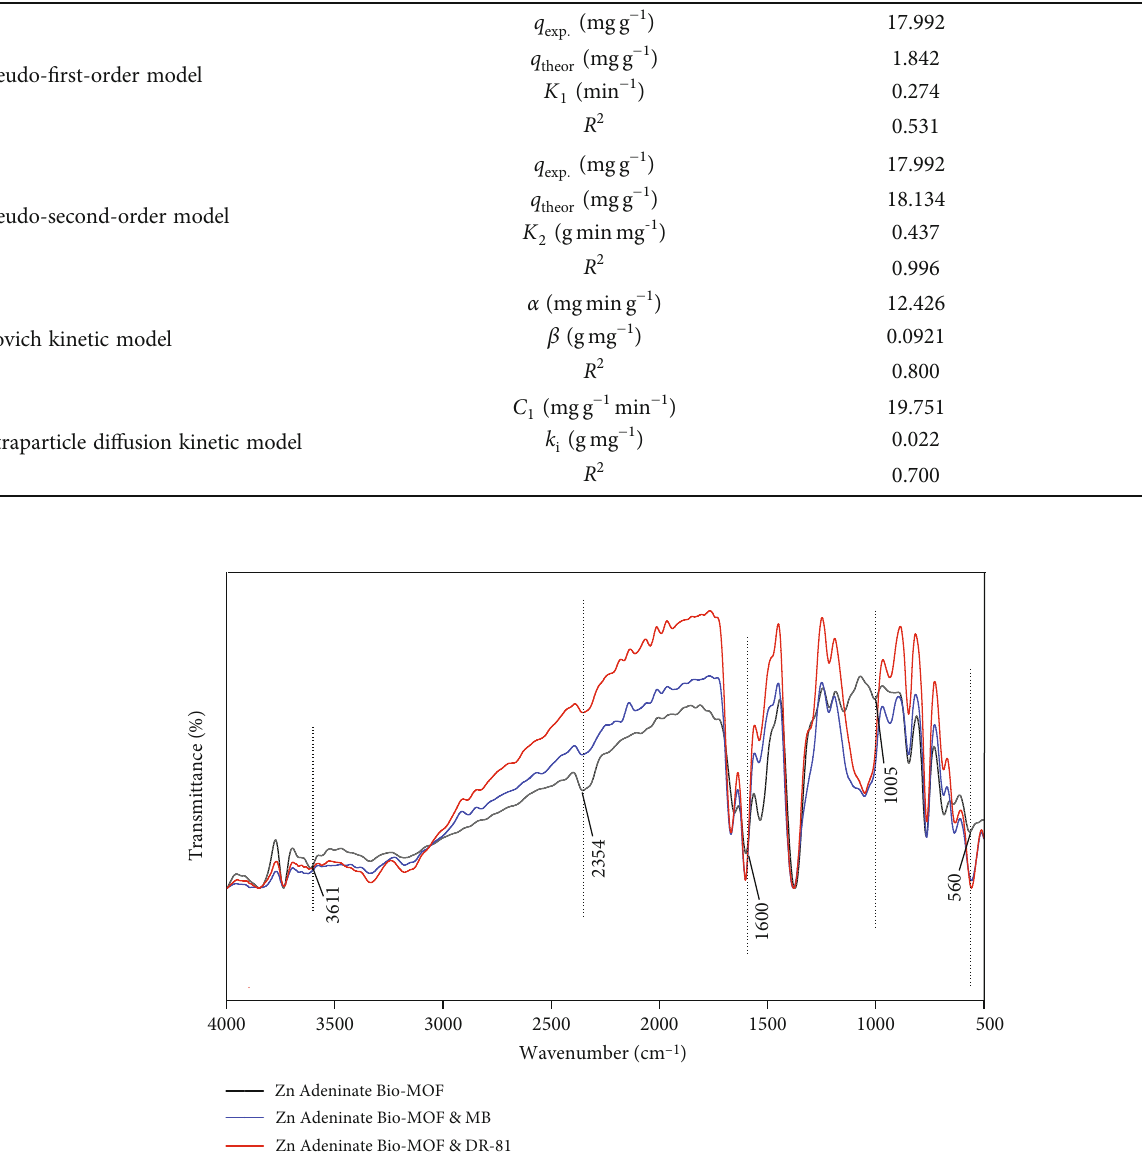
Figure 14: Comparison of the FT-IR spectra of (a) the synthesized Zn-adeninate bio-MOF, (b) Zn-adeninate bio-MOF and MB, and (c) Zn adeninate bio-MOF and